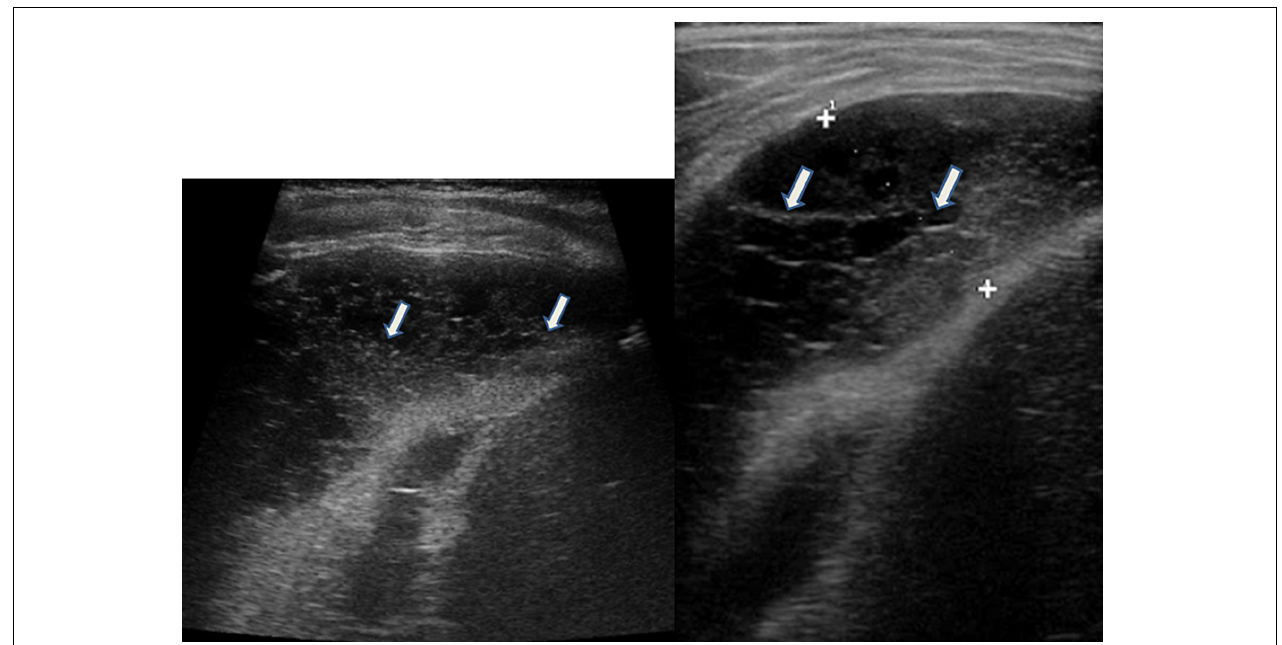
FIGURE 3 | Grayscale lung ultrasound examination (transverse scan between intercostal fields; linear probe with 12 MHz frequency) of a 5-year-old child with pneumococcal pleuropneumonia (complicated by pleural empyema), shows exudative pleural effusion, with internal echoes non-homogeneously distributed: it is fibrinous, plural-septate, and concamerated and with thickened septa ( arrows